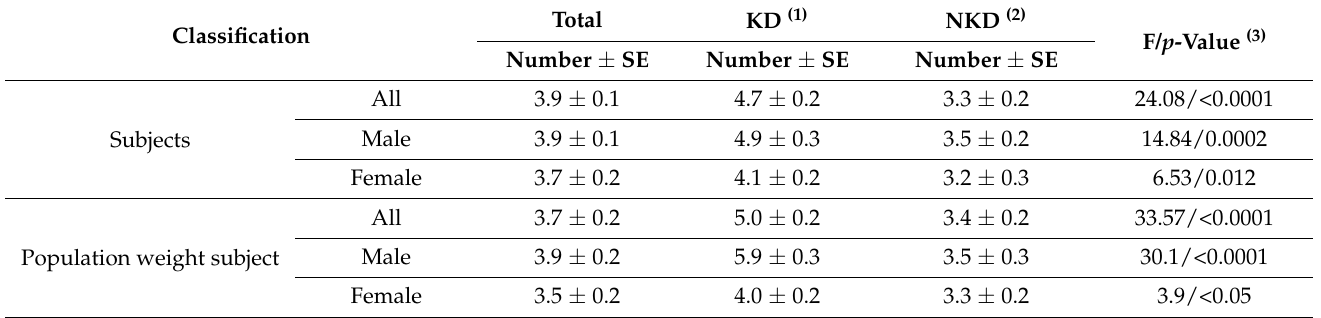
Table 2. Comparison of the number of chronic diseases of the kidney and non-kidney disabled by ANCOVA in five-year KHP pooled data.